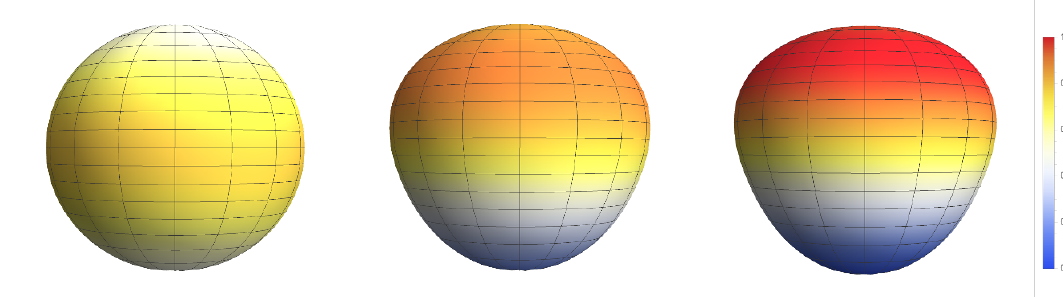
Figure 10 . Pro(cid:12)le of the scalar (cid:12)eld (cid:30) 1 on the horizon. We show here the case for ‘ 2 (cid:11) 1 = ‘ 2 (cid:11) 2 = 0 : 4 M 2 and for a parity-breaking phase (cid:18) m = 0 ; (cid:25)= 4 ; (cid:25)= 2, from left to